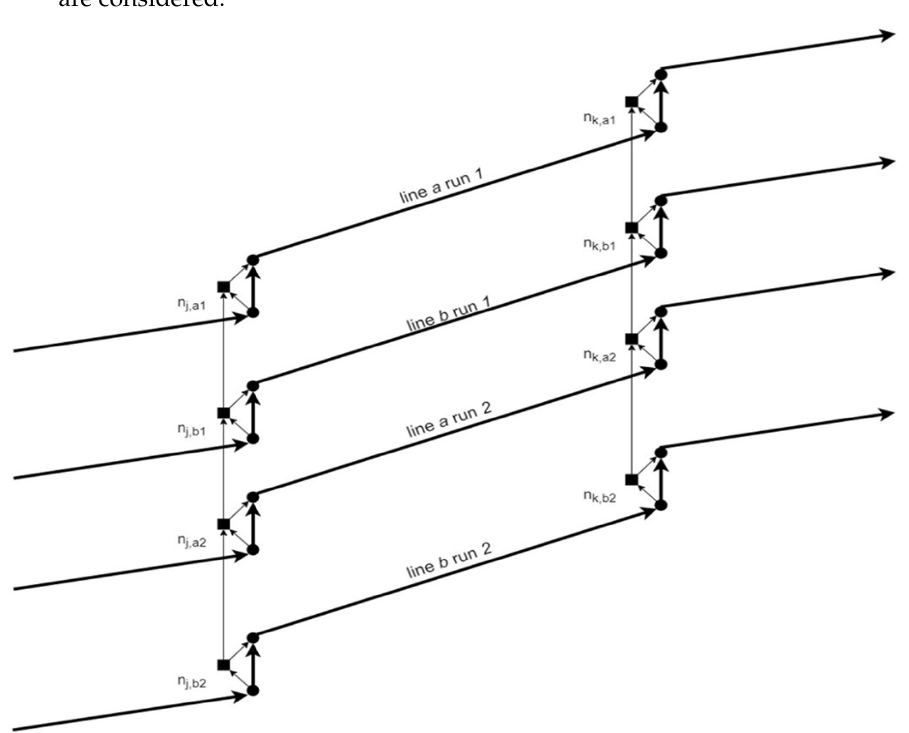
Figure 3. Diachronic network of service subgraph Ω s .